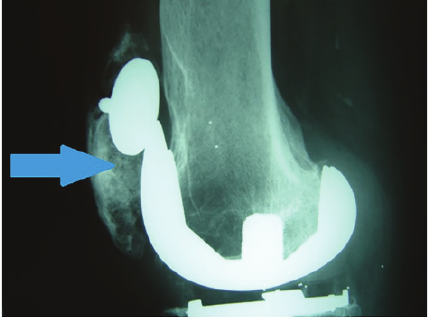
Figure 2: Lateral radiograph of the replaced knee demonstrates the loose patella prosthesis and surrounding